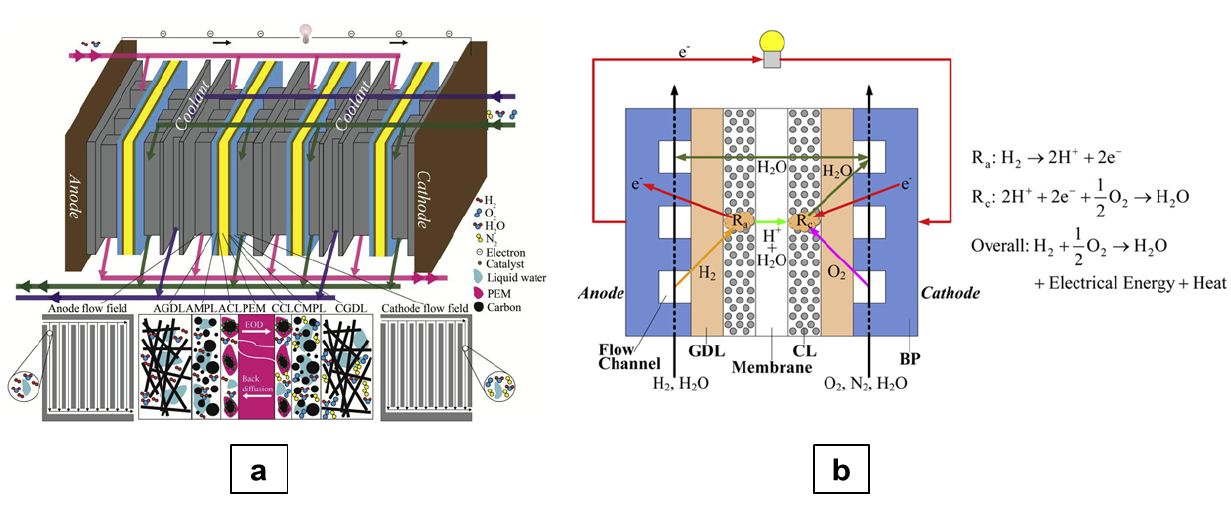
Figure 1. Left ( a ): component of a PEMFC, elaborated from [4]. Right ( b ): sketch of electrochemical reactions and species transport, elaborated from